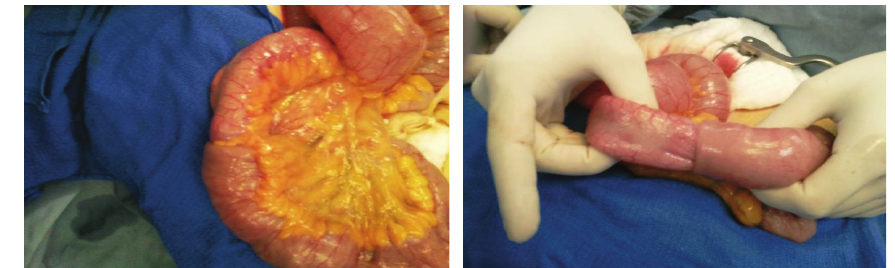
Figure 2: Intraoperative view showing the jejunojejunal intussusception.